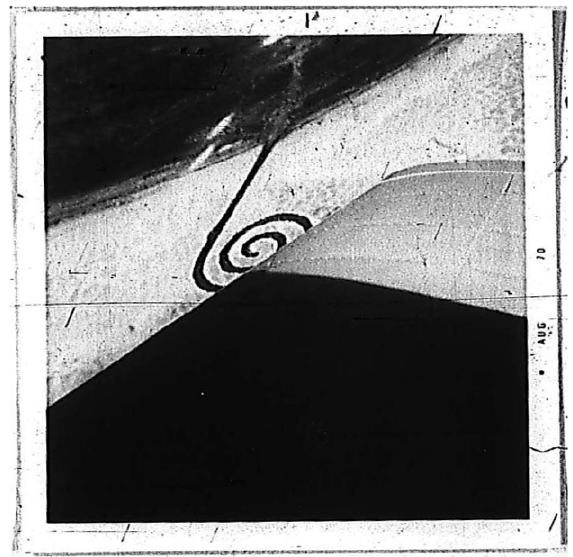
Figure 17. Robert Smithson, Spiral Jetty seen from the plane (Aug, 1970), RSP Reel 3835, Frame